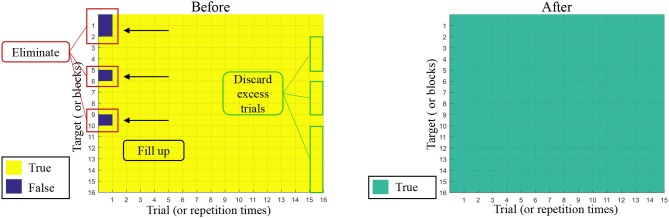
Example for the error trials before and after model modification.